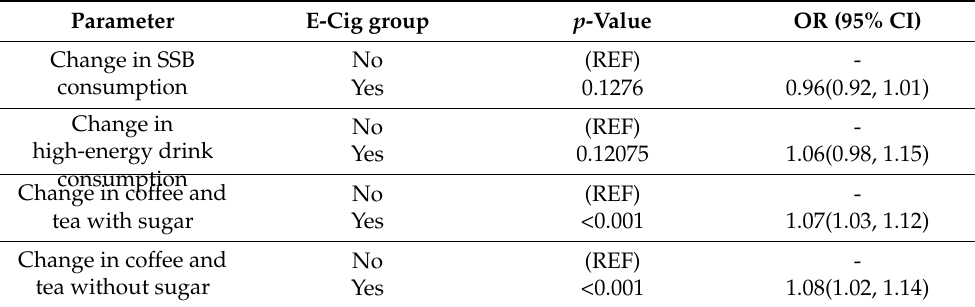
Table 8. Model 4: Longitudinal association between change in beverage consumption (2016/17– 2017/18) and current vaping status (2017/2018) in the COMPASS